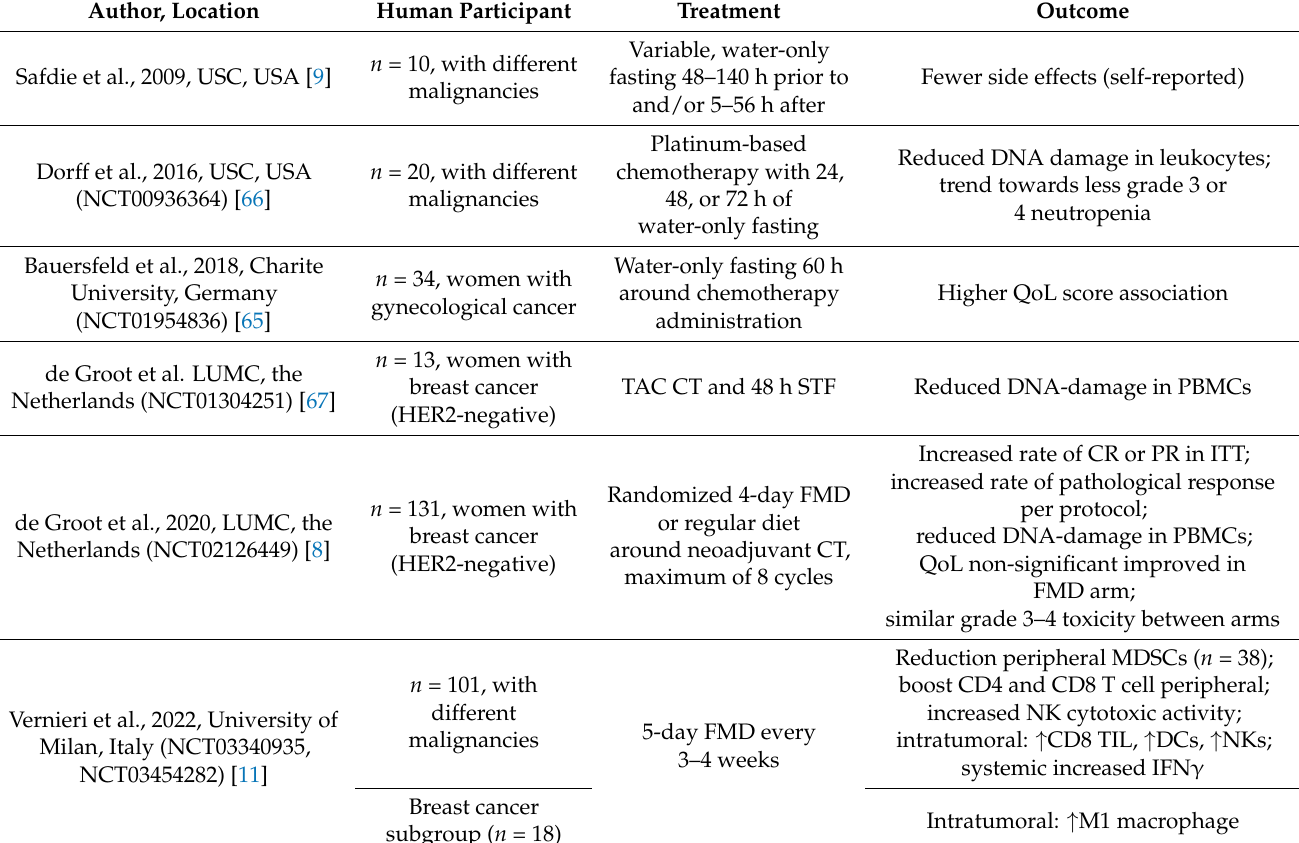
Table 2. Overview of clinical trials observing potential immunomodulatory effects of STF in cancer